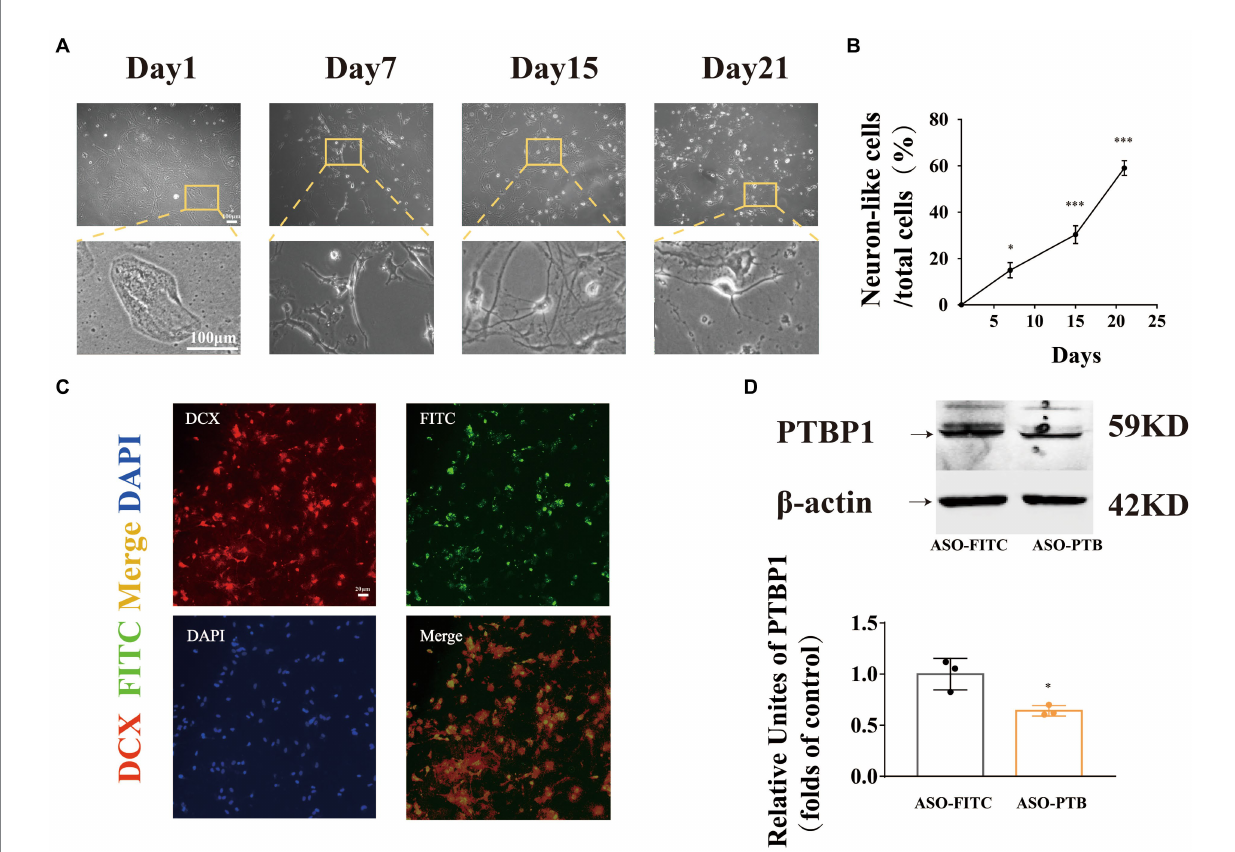
FIGURE 3 Conversion of astrocytes to immature neurons by ASO-PTB in vitro . (A) Mouse primary astrocytes transform into neuron-like cells. Original objective magnification of 4 × (top), the images below are an enlarged image (bottom), Scale bar represents 100 μ m. (B) The length of axons and the number of neuron-like cells increased following incubation (one-way ANOVA, Tukey’s multiple comparisons test, F (3,8) = 120.3 * p = 0.0312, *** p = 0.004, *** p < 0.001 compared to the first day, n = 3). (C) Cortical astrocytes, treated with ASO-PTB, were stained for doublecortin (red) and DAPI (blue); FITC was carried by ASO (green). Scale bar represents 20 μ m. (D) Western blotting and quantification of PTB knockdown in mouse Primary astrocytes (two-tailed unpaired t -test, t = 3.819, df = 4, * p = 0.0188 compared to the ASO-FITC, n = 3). The arrow refers to the target band. Data are expressed as mean ±